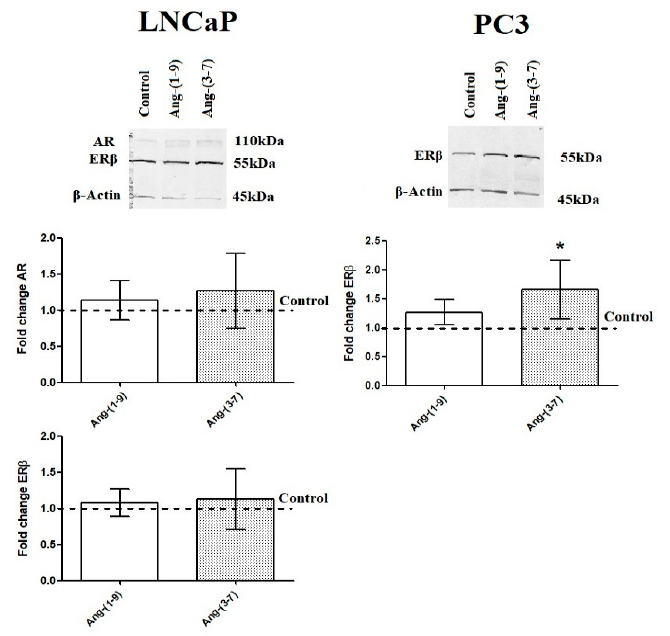
Figure 9. Western blot analysis of androgen receptor (AR) and ERs level in the prostate cancer lines (LNCaP and PC3) after exposure to Ang-(1-9) or Ang-(3-7) at a concentration of 1 nM for 48 h (mean ± SD; Tukey’s test: * p <